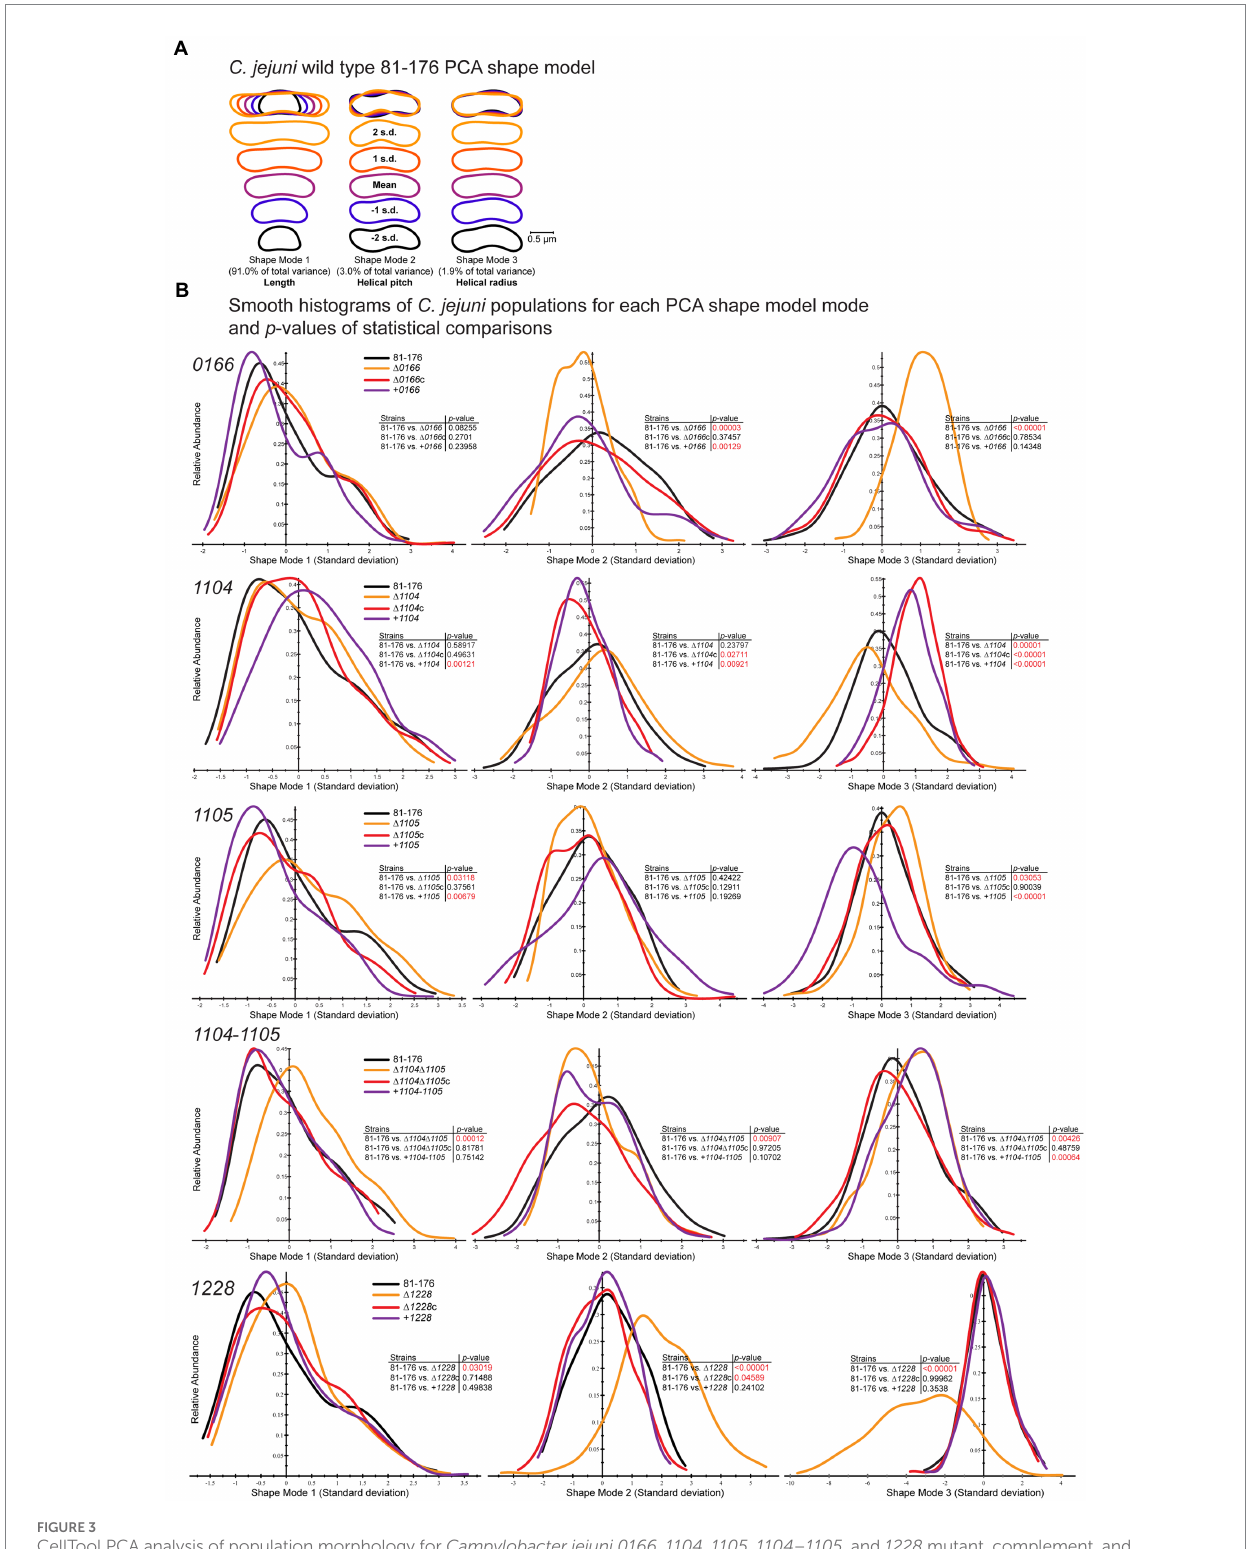
FIGURE 3 CellTool PCA analysis of population morphology for Campylobacter jejuni 0166 , 1104 , 1105 , 1104 – 1105 , and 1228 mutant, complement, and overexpressor strains. Campylobacter jejuni strains grown to the mid-exponential phase were imaged by DIC microscopy. The images were converted to binary, and cell contours were extracted and aligned. (A) A C. jejun i wild-type shape model was generated from aligned contours by PCA analysis to explain 94.9% of the population variation with the principal component shape modes 1–3. The mean shape mode ±2 standard deviations (s.d.) are shown. Shape mode 1 represents length, shape mode 2 helical pitch, and shape mode 3 helical radius. CellTool was then used to align the contours of mutant and associated complemented and overexpression strain population morphologies to the wild-type shape model. (B) Measurements representing the normalized standard deviations from each wild-type shape mode relative to abundance are represented as a histogram for each mutant ( ∆ 0166 , ∆ 1104 , ∆ 1105 , ∆ 1104 , ∆ 1105 , and ∆ 1228 ), complement ( ∆ 0166c , ∆ 1104c , ∆ 1105c , ∆ 1104 , ∆ 1105c , and ∆ 12285 ), and overexpressor (+ 0166 , + 1104 , + 1105 , + 1104 – 1105 , and + 1228 ). The analyses are grouped by gene: 0166 , 1104 , 1105 , 1104 – 1105 , and 1228 . The p -values comparing each strain to the wild type were determined by the Kolmogorov–Smirnov statistics and are shown as an inset to each graph. Values in red highlight statistically significant comparisons with p -values of <